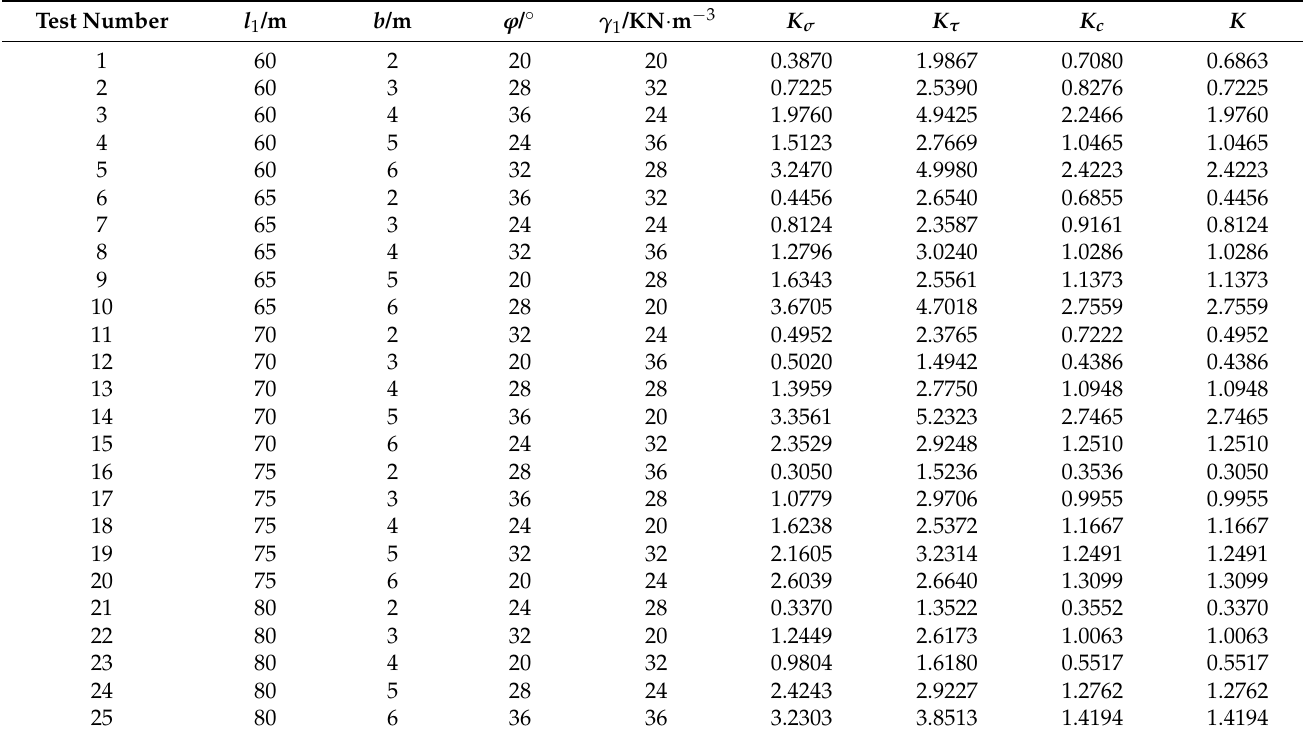
Table 2. Orthogonal test table of mine wall safety factor.